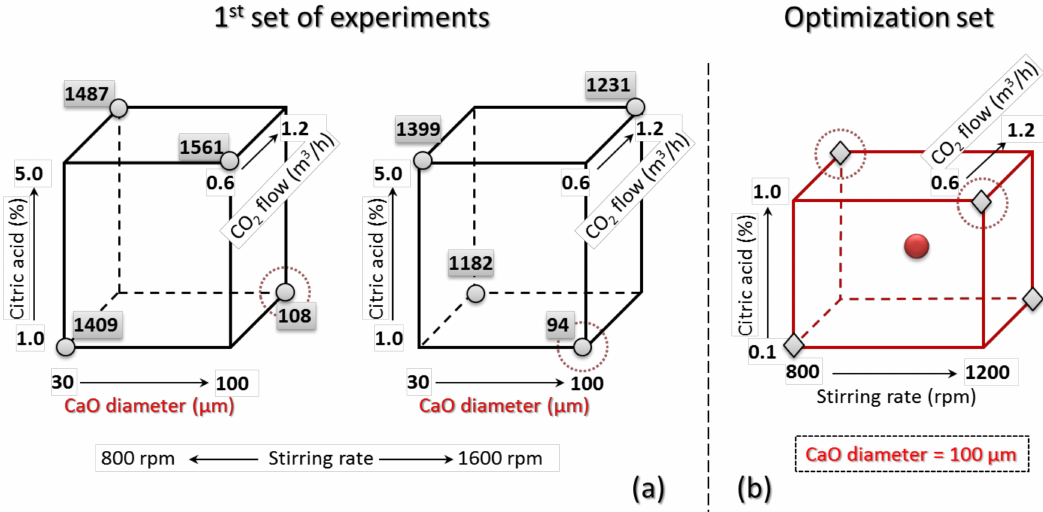
Figure 6. Cube plots for the DoE: each dimension of the 3D plot represents a different factor, with the selected two levels at the vertices. In ( a ), the numbers at the corners are the responses (mean size of calcite particles) from the first FFDoE set (the two cube plots differ only for the level of the fourth factor, the stirring rate); ( b ) optimized FFDoE with highlighted second set of five experimental runs, comprising one for each factor/level combination (diamonds) and one additional mean run (circle); the dotted circles refer to run P10 and P13 in the optimized set (see Table 2), corresponding to runs P6 and P2 of the first FFDoE, respectively; that is, those that gave the two best